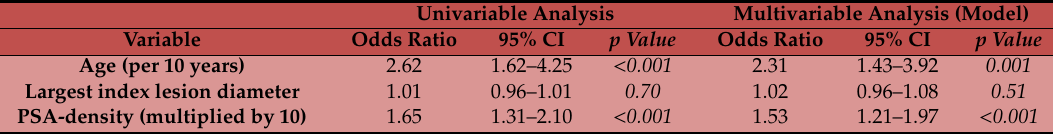
Table 3. Output of the logistic regression analyses.